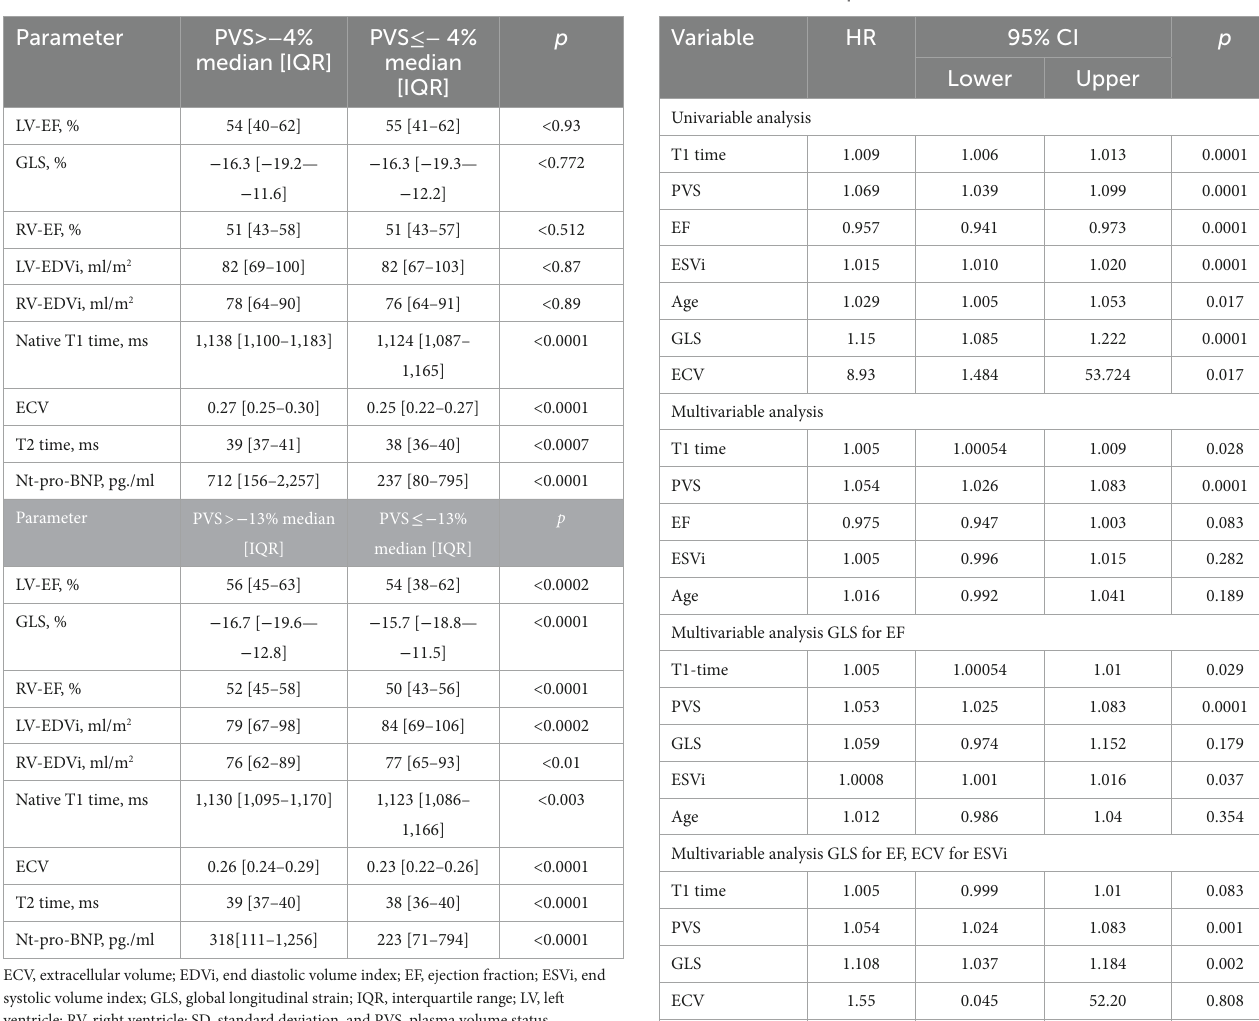
TABLE 4 Cox regression analysis for the primary endpoint of cardiovascular death/heart failure